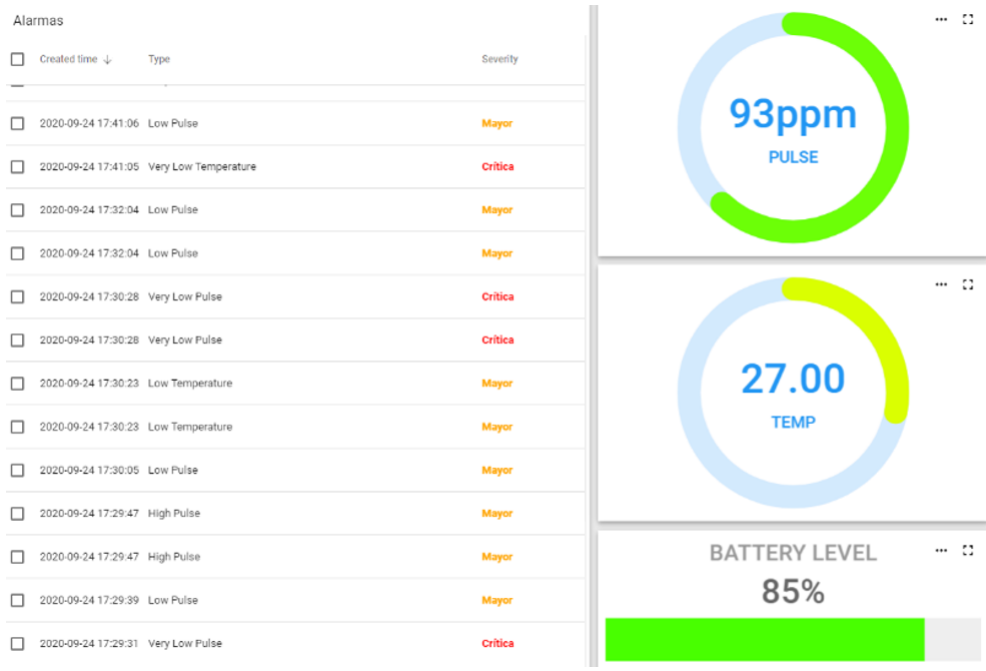
Figure 6. BeSafe B2.0 Platform, bracelet alarm